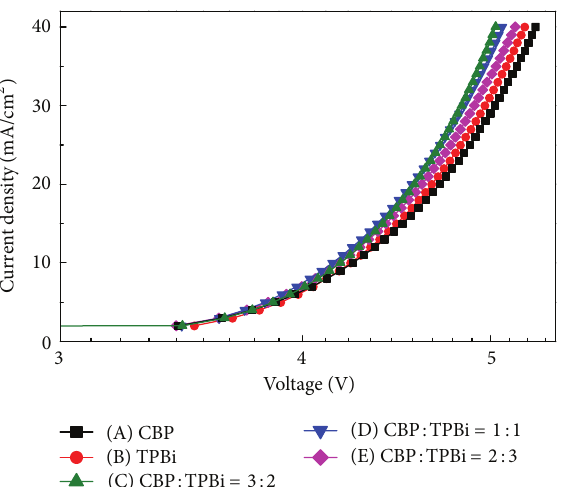
Figure 2: The relationship of current density versus voltage in the semilogarithmic scale of HWOLEDs (Devices A, B, C, D, and E).